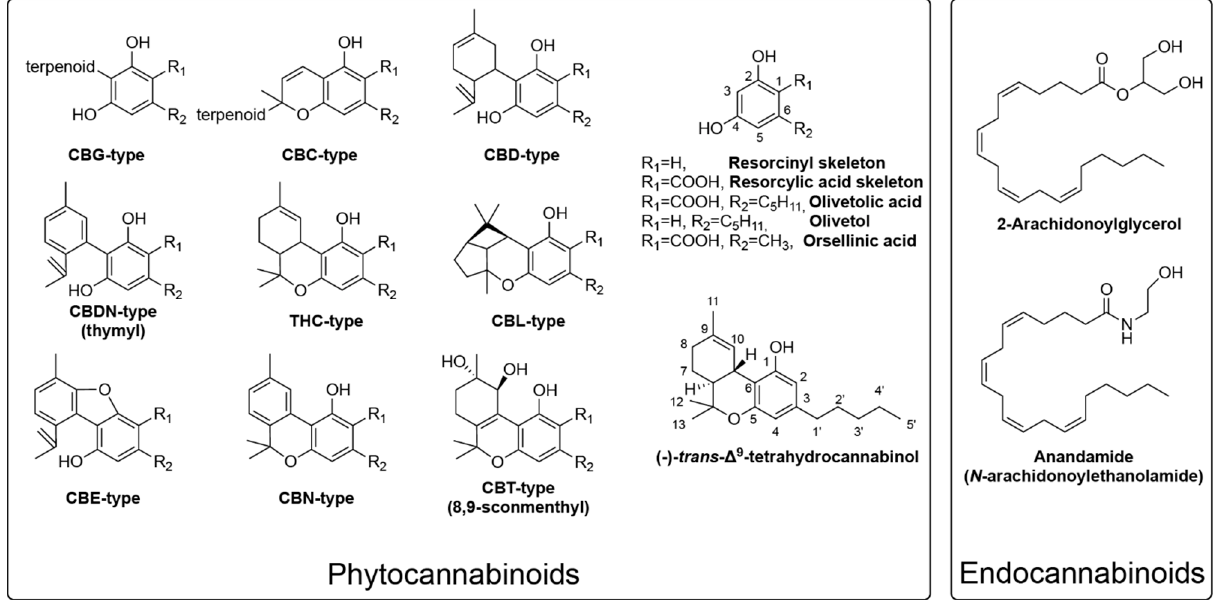
Figure 1. Representative structures for endocannabinoids, phytocannabinoids, intermediates and numbering system.